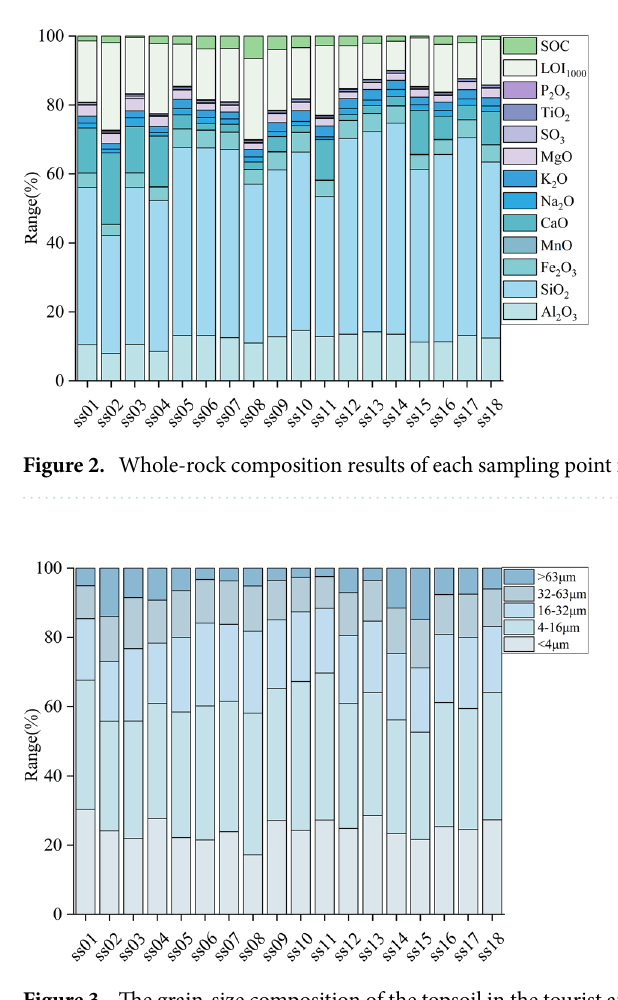
Figure 3. The grain-size composition of the topsoil in the tourist area of Sayram